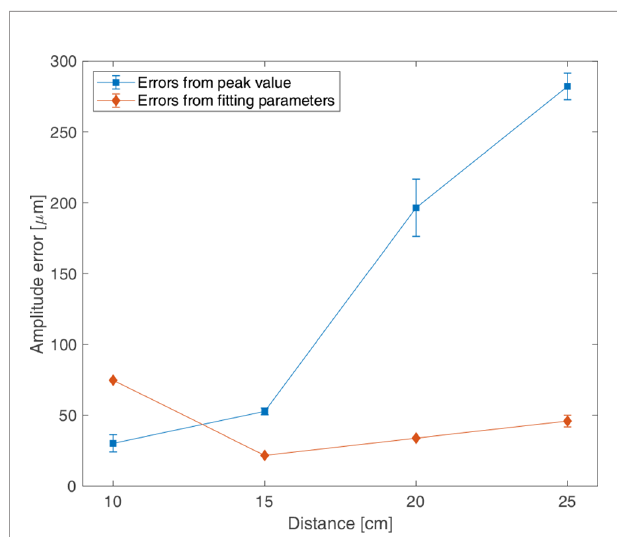
FIGURE 7 | Amplitude errors for the distance between the sensor and magnet according to the motion phantom moving in sinewave of 3 s periods and of 10 mm amplitude (P-P); the errors from peak values (in blue and ■ ), the errors from fi tting parameter (in pink and ◆